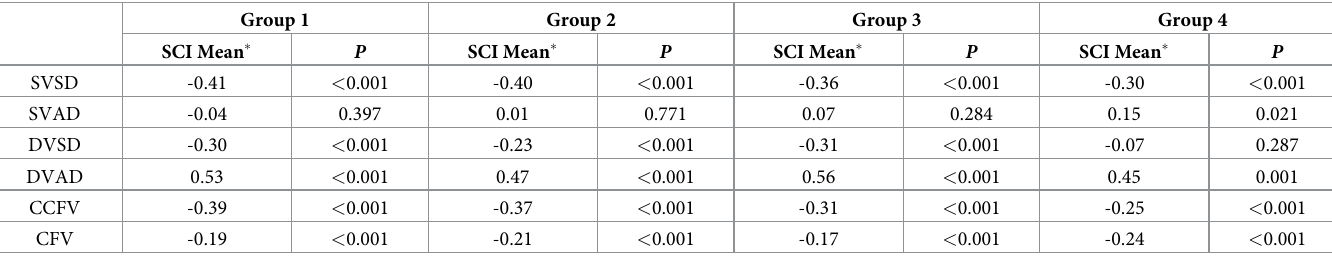
Fig 3. Zeiss and Heidelberg comparison using the SVAD parameter in each diabetic retinopathy severity group. Bland-Altman plots. A: Zeiss and Heidelberg are consistent in Group 1. B: Zeiss and Heidelberg are consistent in Group 2. C: Zeiss and Heidelberg are consistent in Group 3. D: Zeiss and Heidelberg are inconsistent in Group 4. The solid line indicates the mean of the differences; the upper and lower dotted lines indicate the upper and lower limits of agreement (LA). Group 1: nondiabetic controls; Group 2: diabetes without DR; Group 3: mild NPDR; Group 4: severe NPDR and PDR. https://doi.org/10.1371/journal.pone.0234664.g003 Table 3. SCIs of OCTA parameters within DR severity stage